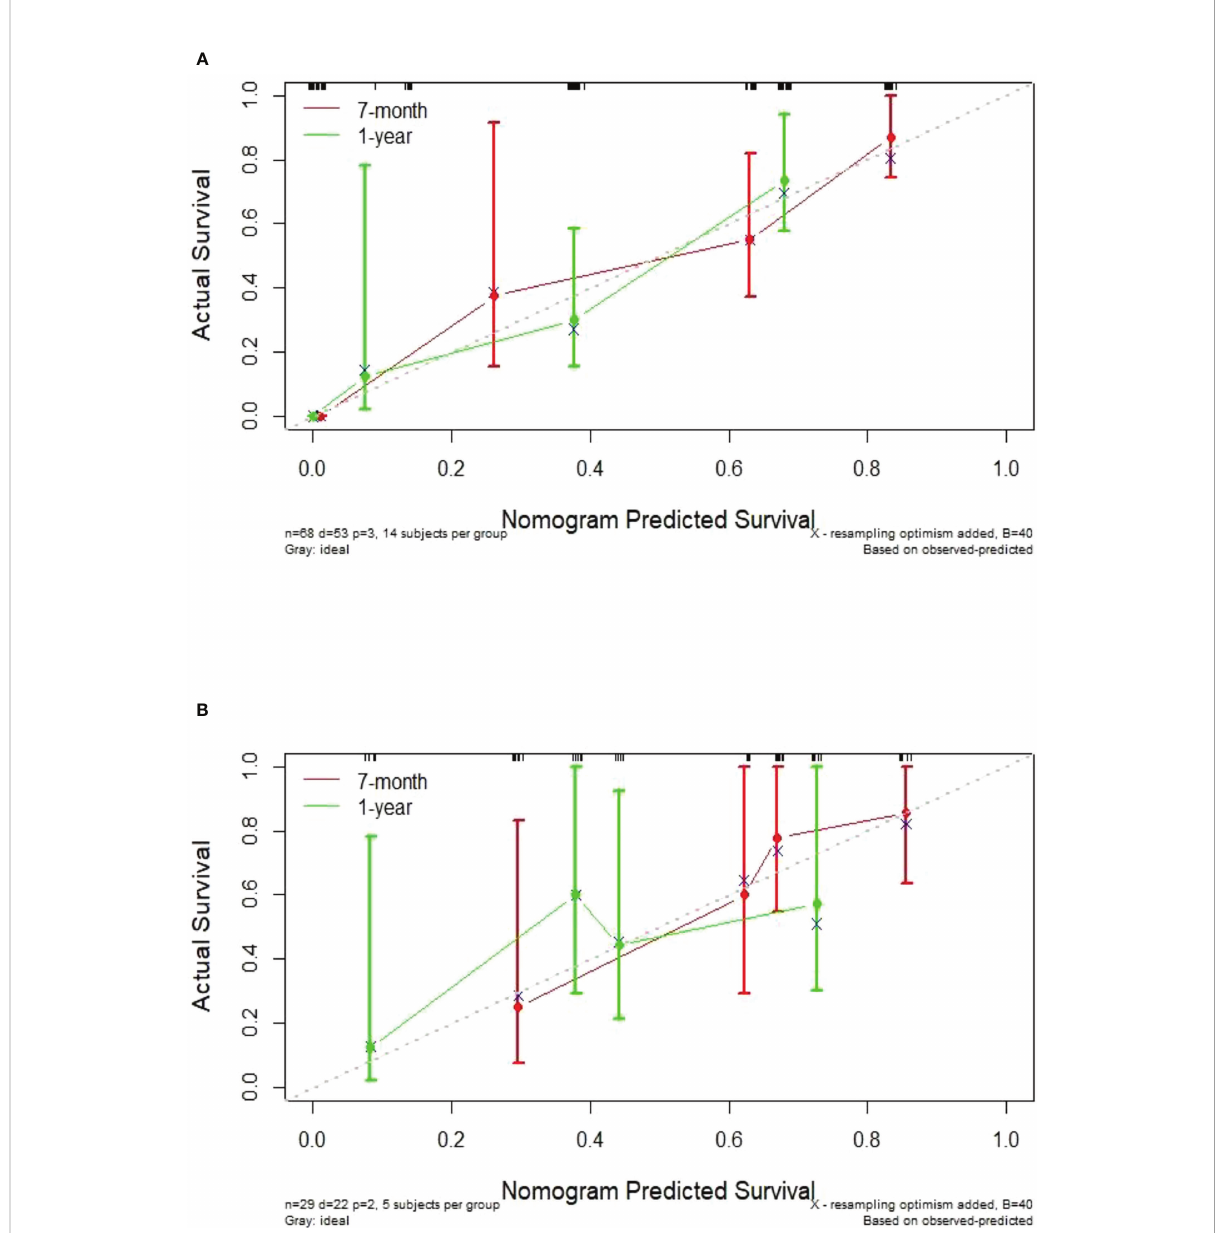
FIGURE 6 Calibration curves showing an excellent agreement between the predictions and observations of the 7-month and 1-year NSCLC progression probabilities in the training cohort (A) and validation cohort (B)